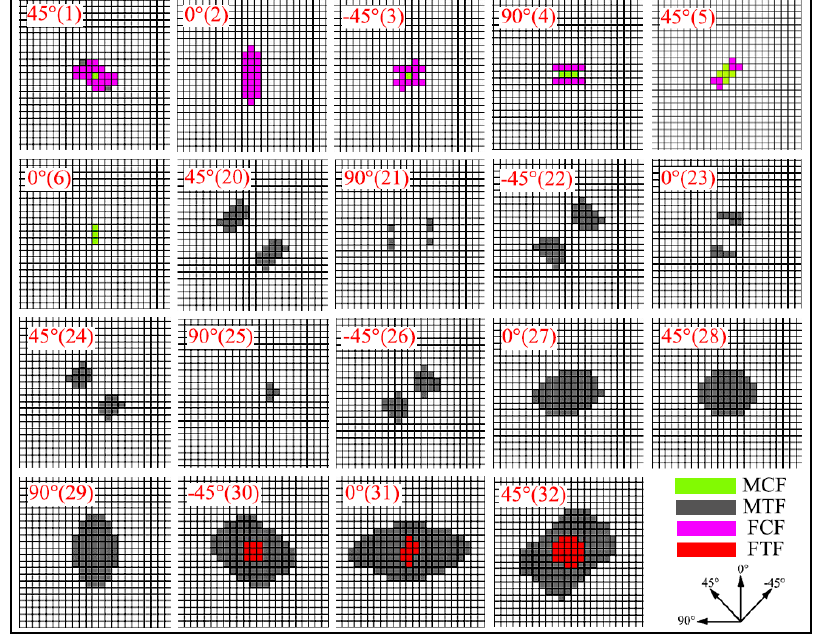
Figure 6. Final failure of each layer after the impact of 16.8 J.